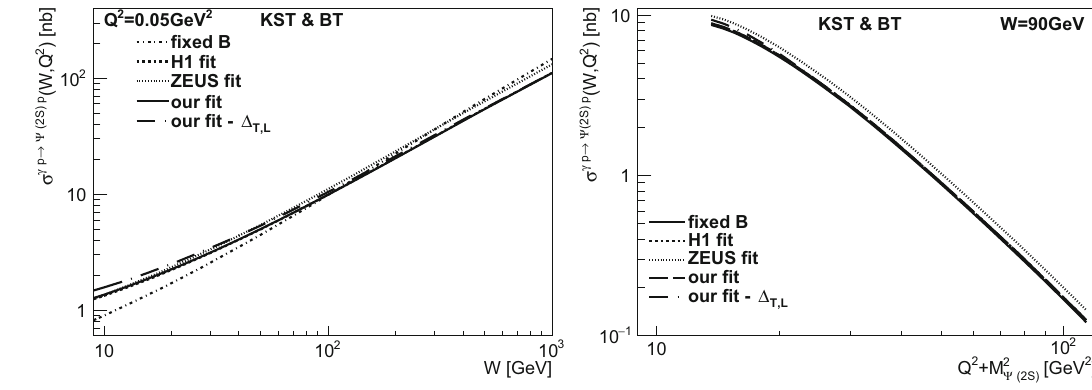
Fig. 9 The same as Fig. 7 but for the real and virtual photoproduction of ϒ (cid:2) ( 2 S ) bottomonia